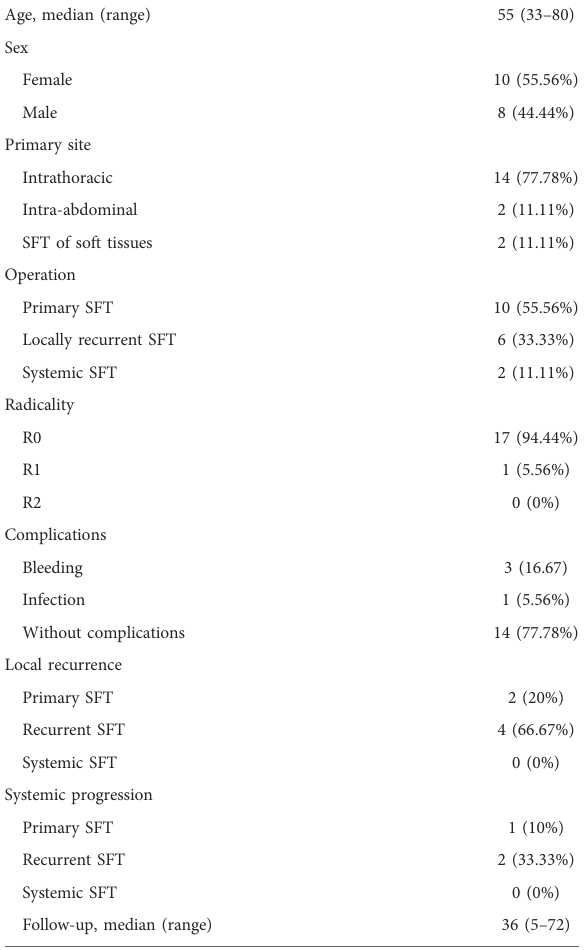
TABLE 1 Data associated with the provided surgery and the outcome of the patients. Clinical data of the